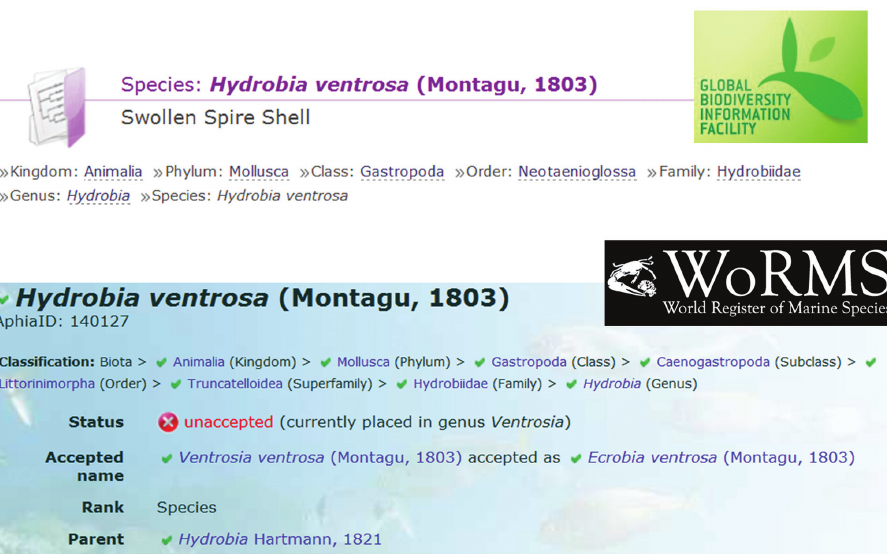
Figure 5. Some details about the results of searching Hydrobia Ventrosa in GBIF and WoRMS online taxonomic